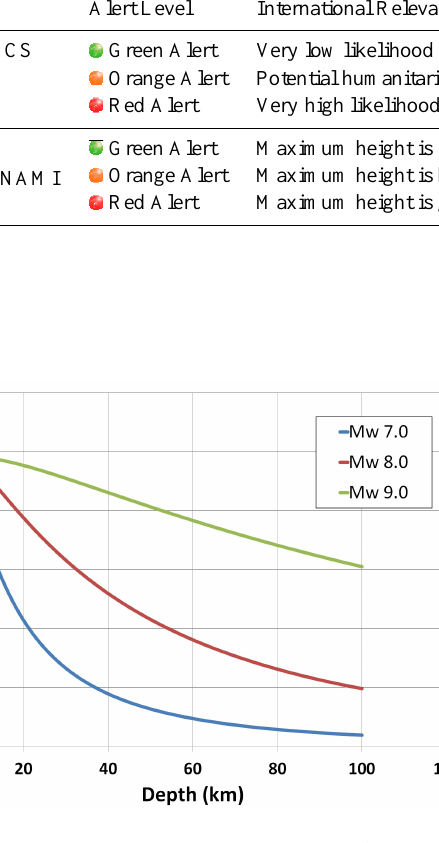
Fig. 4. The reduction factors due to the depth of the fault for the magnitudes of 7.0, 8.0 and